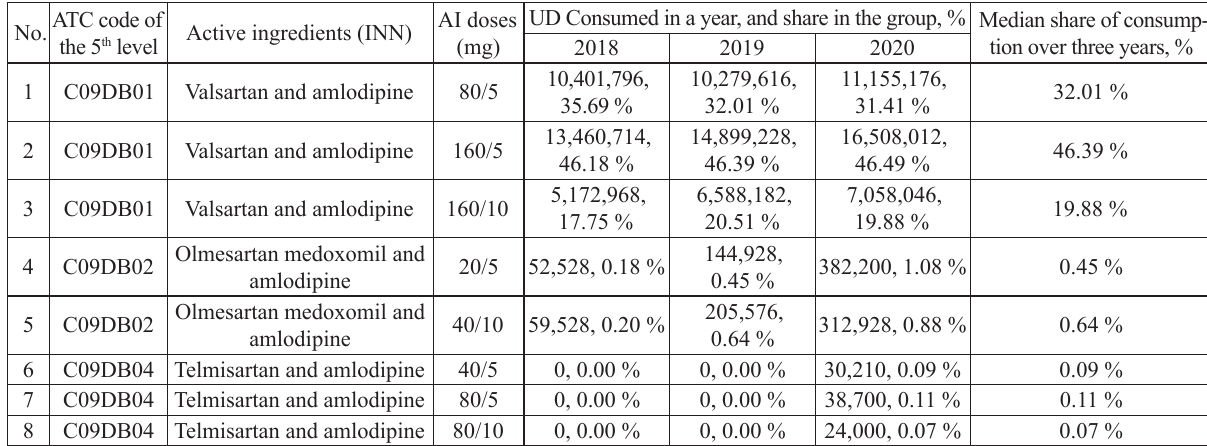
Consumption of fixed-dose ARB and CCB combinations in Ukraine in 2018-2020 ATC code of No. Active ingredients the 5 th level